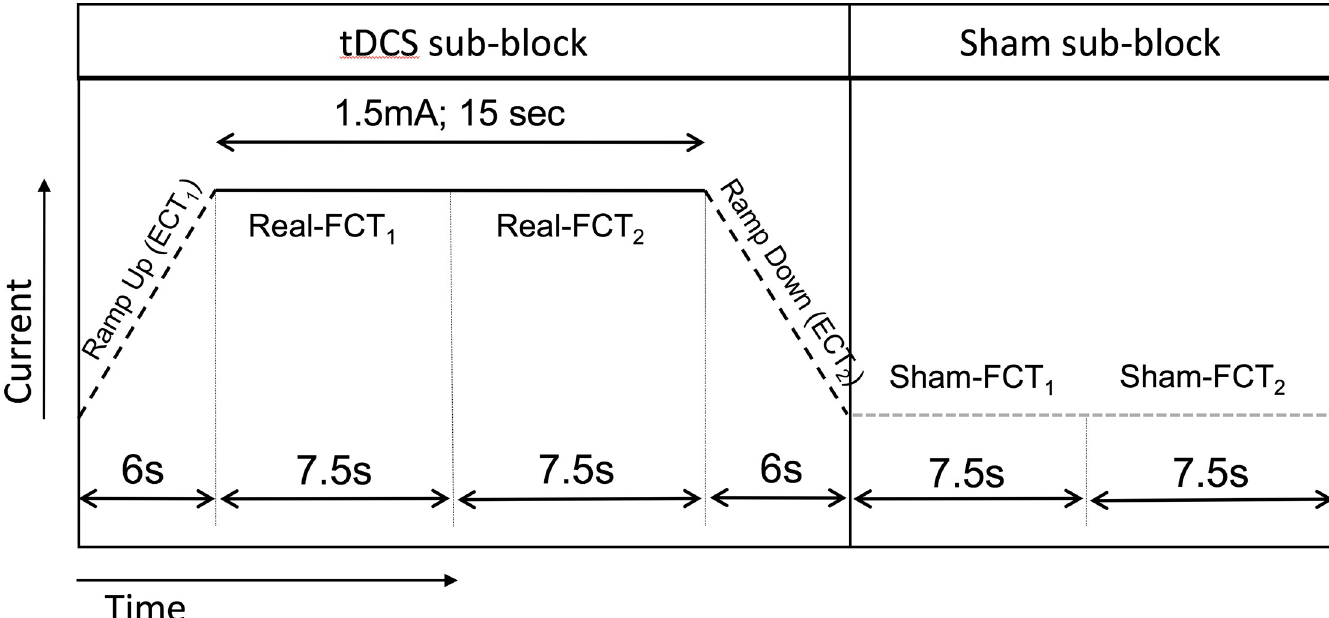
Fig 2. Illustration of the stimulation protocol. The tDCS sub-block included one externally-cued trial (ECT 1 ), 2 consecutive free-choice trials (FCT 1 and FCT 2 ) followed by a second externally-cued trial (ECT 2 ). Current was ramped up over 6s duration of ECT 1 . A constant current of 1.5mA was delivered during FCT 1 and FCT 2 . This was followed by ramping down of the current over 6s during ECT 2 . The whole experiment consisted of 4 blocks and each block had 16 tDCS and 16 sham sub- blocks occurring in a random order. This yielded 32 free-choice trials with anodal/cathodal tDCS; 32 free-choice trials with sham stimulation and 32 externally-cued trials in every